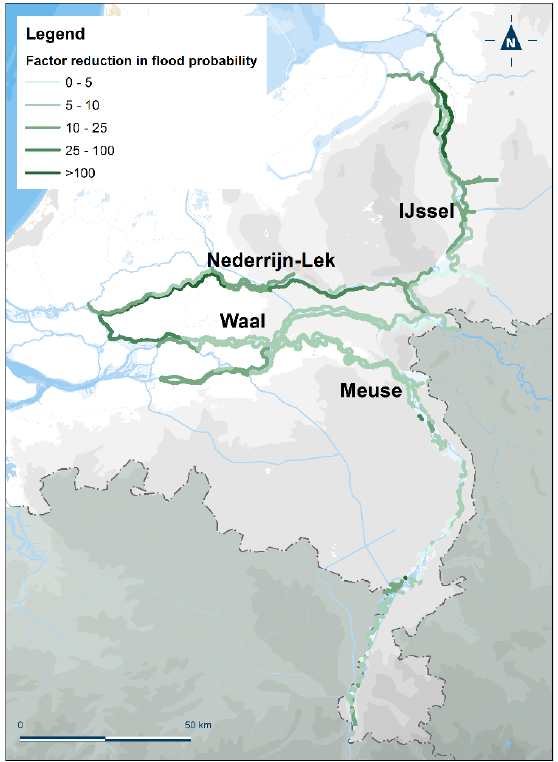
Figure 6. Decrease in probability of breaching (factor) resulting from 0.5 m lower flood levels in the river.